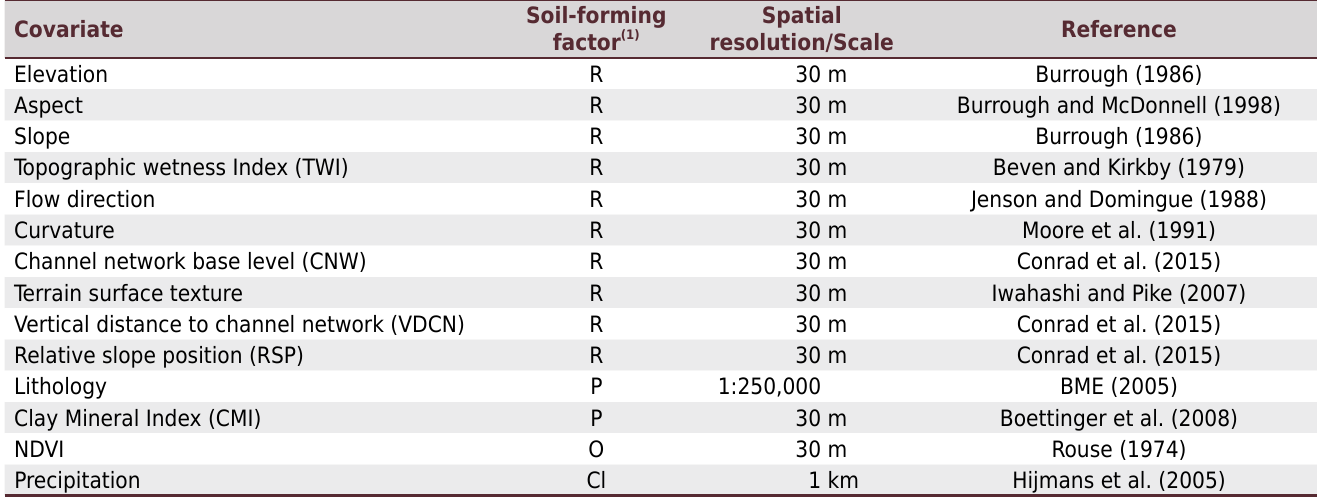
Table 2. Covariates evaluated as soil predictors